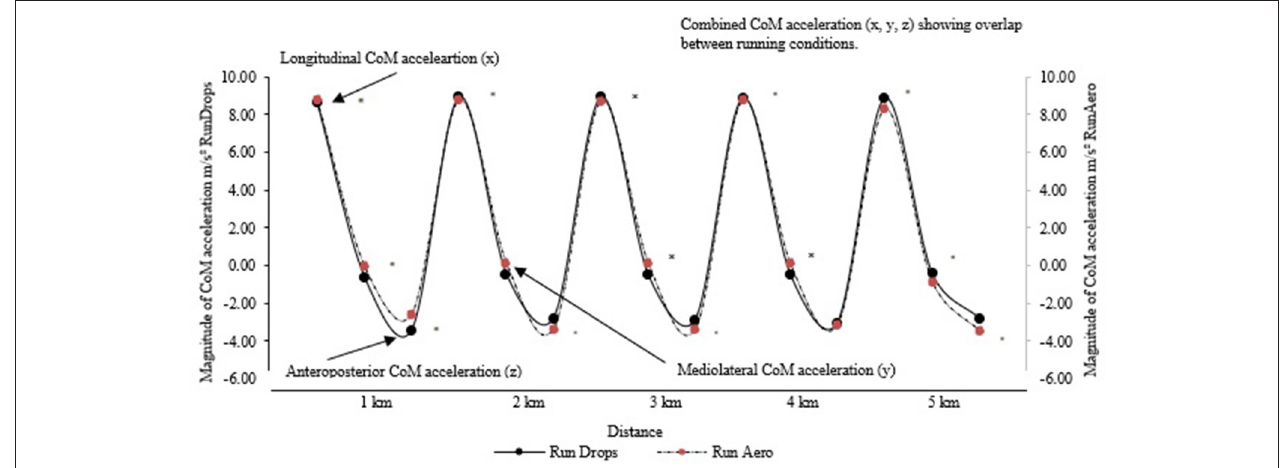
FIGURE 5 | Mean sinusoidal time series representation of triaxial acceleration magnitude where LN = longitudinal (x), ML (y) = mediolateral (y); and AP (z) = anteroposterior torso acceleration in running after aero (dashed line) and drops (solid line) cycling for 10 participants (in m/s 2 ). The resulting trajectories from each gait cycle were subsequently overlayed to observe possible differences between steps. The overlay plot is a time-based in which the mean magnitude was plotted as a function of time Axy(t) vs. (t). The mean triaxial acceleration magnitude was plotted for each 1km for the designated duration. p < 0.05.